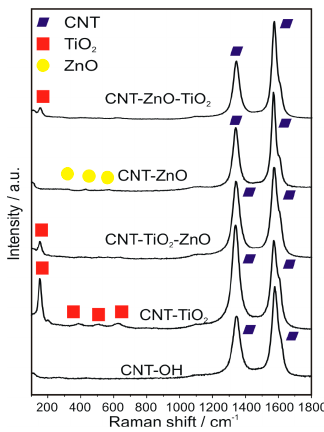
Figure 2. Raman spectra of the samples.